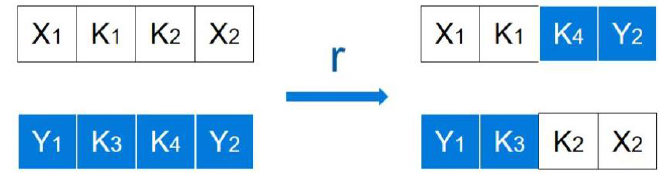
Figure 1. The splicing operation.